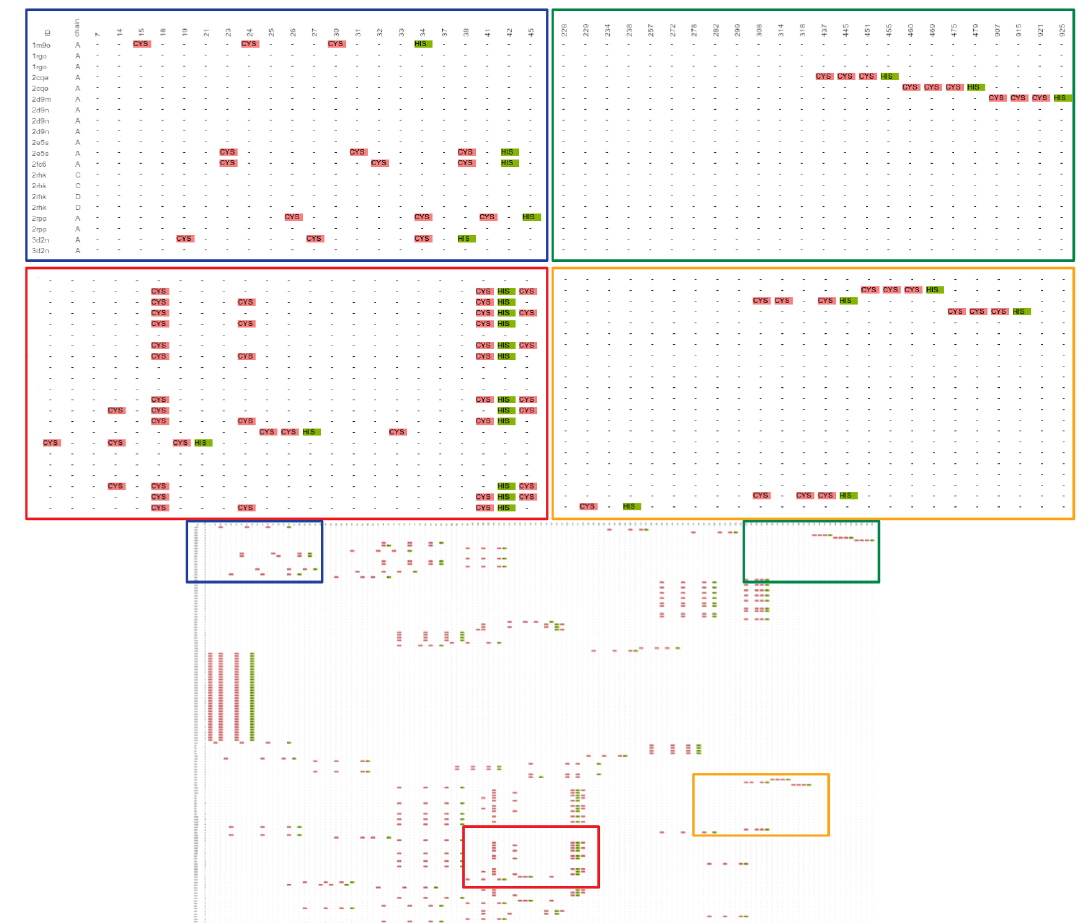
Figure 3. Sequence representation of the structural alignment of the 152 sites detected in the cluster 3C1H-1. This result is delivered by 3D-PP. The diffuse lower box shows the entire representation of the sequence alignment of the 152 sites found. The blue and green boxes show a zoom denoting the PDBids, the chain and the original PDB residue number of each site. The red and orange boxes exemplifies that some 3D-patterns found exhibit the expected sequence order (C-x(8)-C-x(5)-C-x(3)-H), whereas other sites, while having the same structural orientation, do not match with the canonical Zinc finger C3H1-type